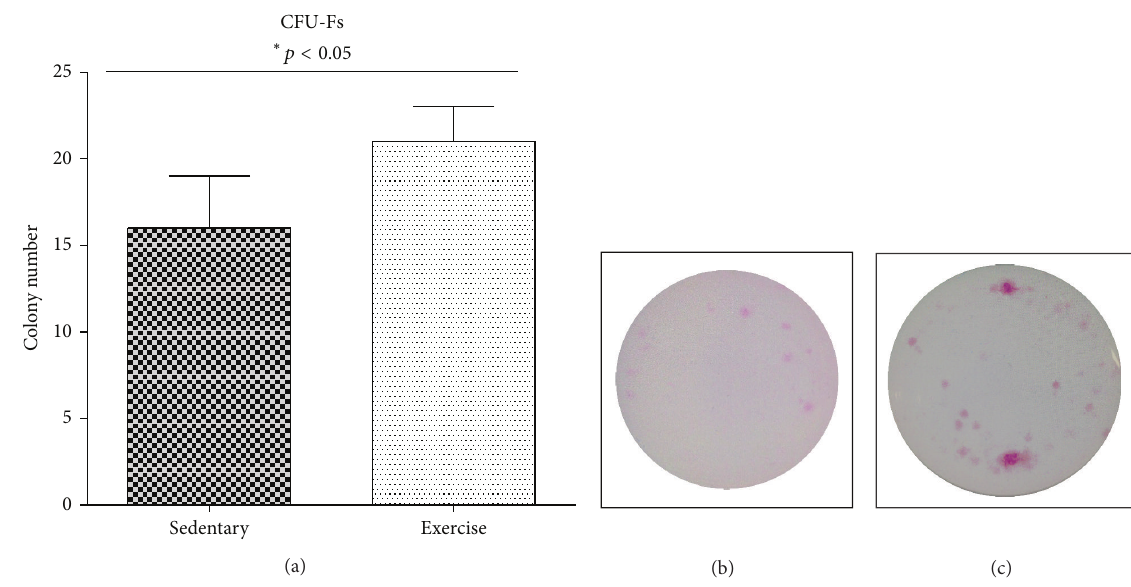
Figure 2: The number of MSC colony-forming units (CFU-Fs) (a). Representative images of stained cells collected from sedentary (b) and exercised (c)